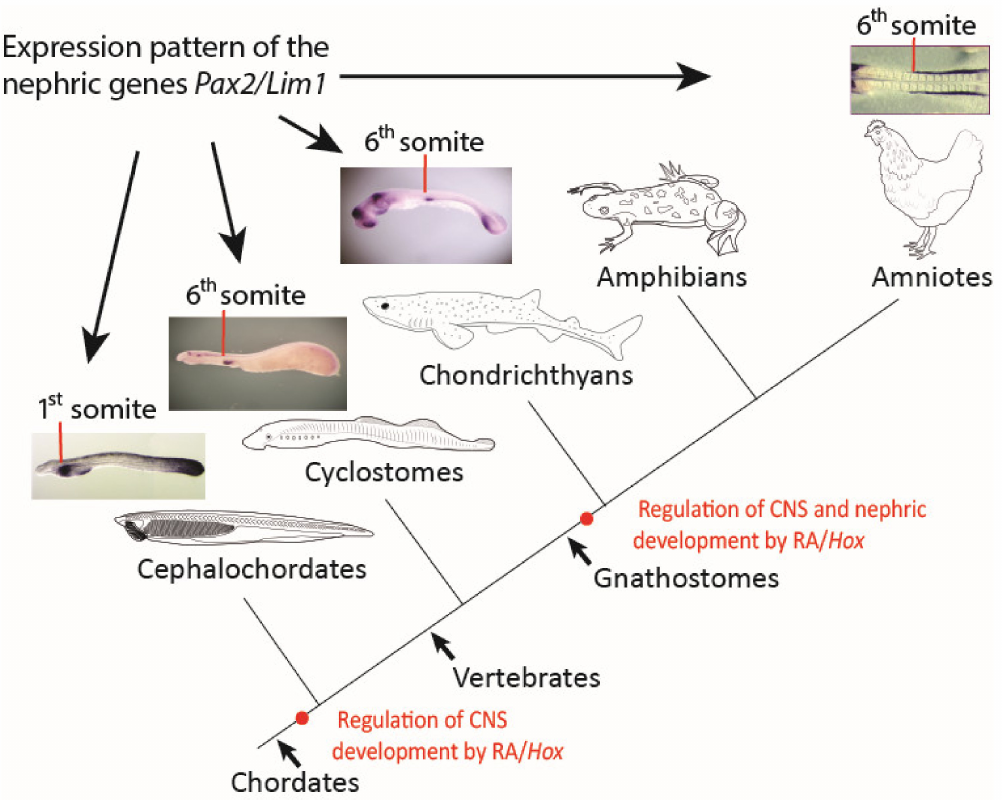
Figure 6. Scenario for the evolution of pronephric patterning in chordates. A scheme describing the main events in the regulation of the nephric system in chordates. Red lines mark the anterior limit of early nephric gene expression. Red dots mark the evolutionary origin of retinoic acid (RA) signaling- and Hox gene-dependent (RA/ Hox ) regulation of different embryonic tissues. CNS, central nervous